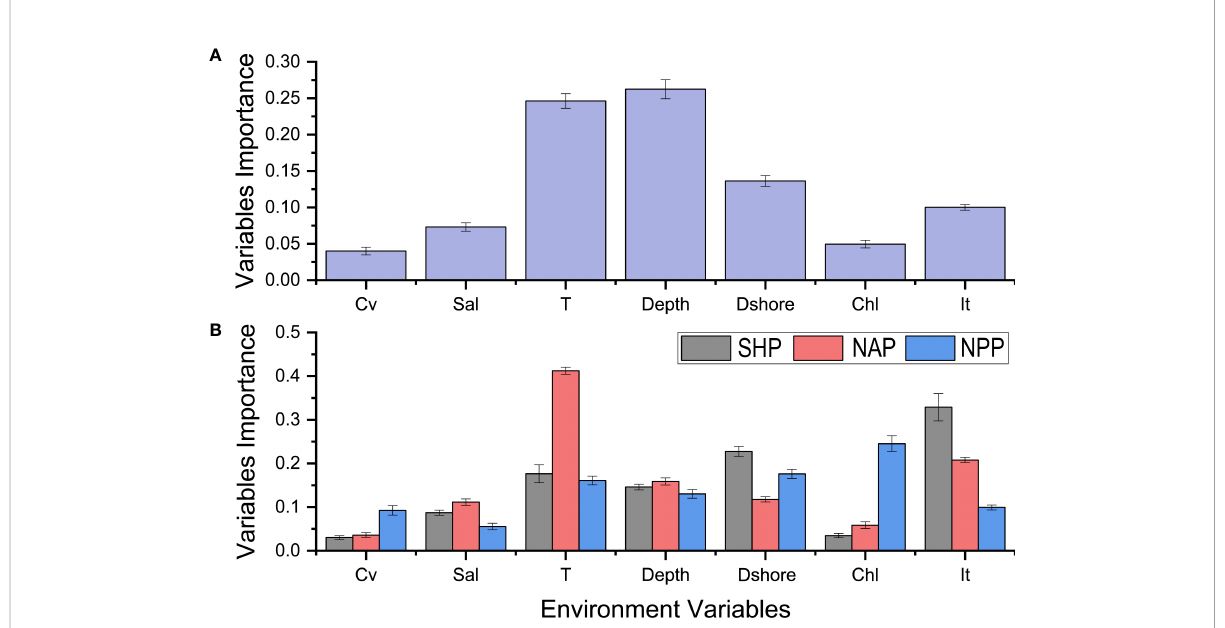
FIGURE 4 The importance of environmental variables in driving the whole-species distribution based on the species-level model (A) and the population distributions based on the population-level model (B) . Cv, current velocity; Sal, salinity; T, temperature; Depth, water depth; Dshore, distance to shore; Chl, chlorophyll concentration; It, ice